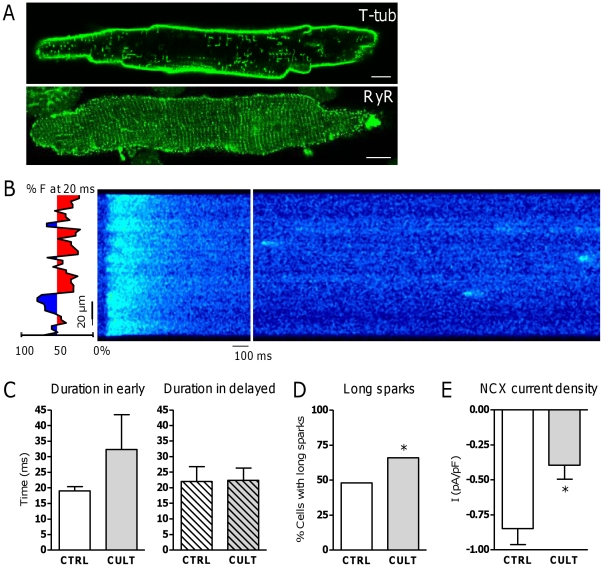
Modulation of Ca2+ sparks with TT loss during culture.A. Representative confocal images of TT staining with di-8-ANEPPS (left) and RyR staining (right) after 48 hours of culture. B. Representative line scan image of Ca2+ spark protocol in CULT. The type of release areas is marked in blue and red for early and delayed release areas respectively. C. Comparison of spark duration in early (left) and delayed (right) release areas in CTRL (Npigs = 7, ncells = 29) vs. CULT (Npigs = 7, ncells = 14). D. Fraction of cells showing long-lasting sparks (>47.6 ms) in CTRL (17/35 cells with long sparks) and CULT (10/15 cells with long sparks). E. NCX current density in CTRL (Npigs = 4, ncells = 14) and CULT (Npigs = 4, ncells = 7). * denotes P<0.05.